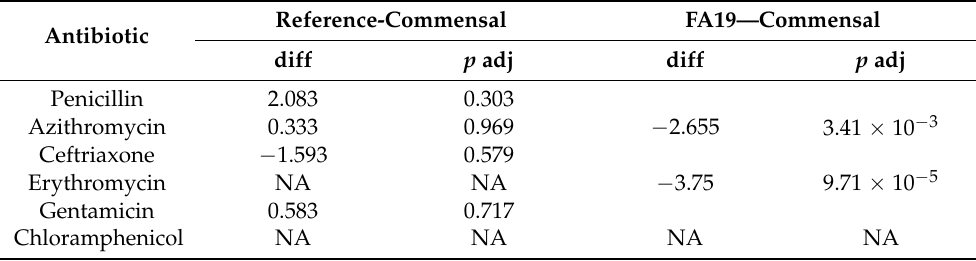
Table 4. Differences and adjusted p -values of the One-way ANOVA pairwise comparison between the reference susceptible and the commensal